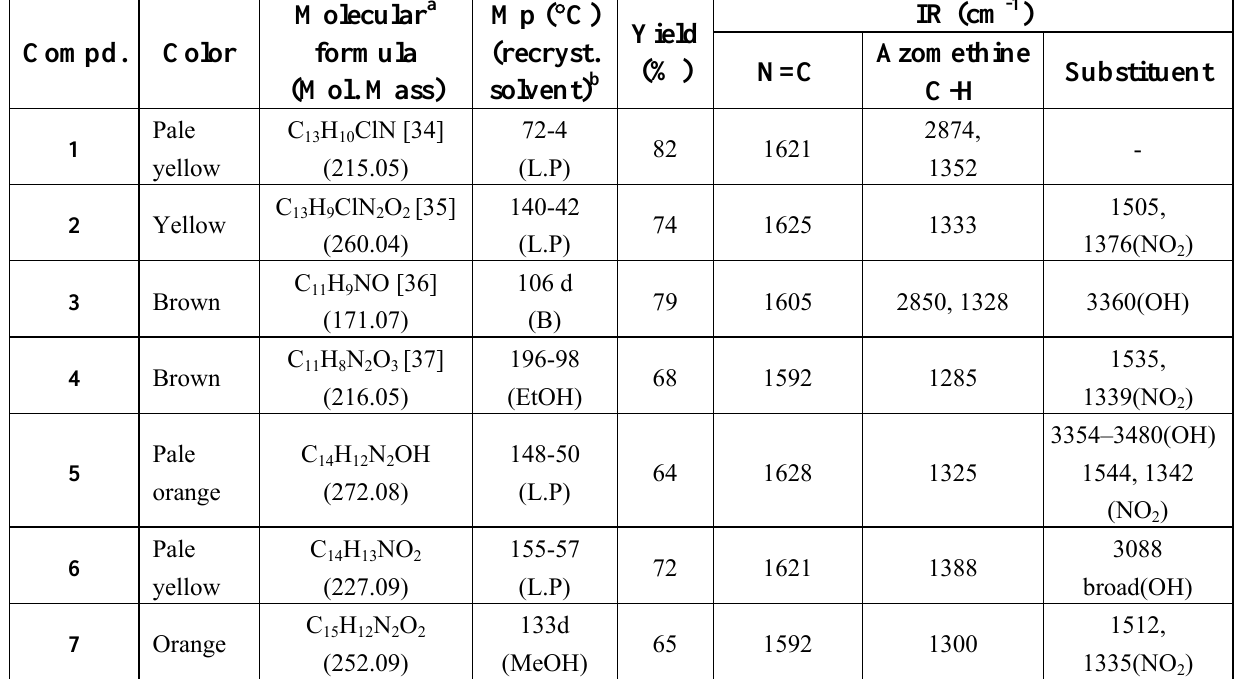
Table 1. Physical and select IR data of the synthesized azomethines 1 - 18